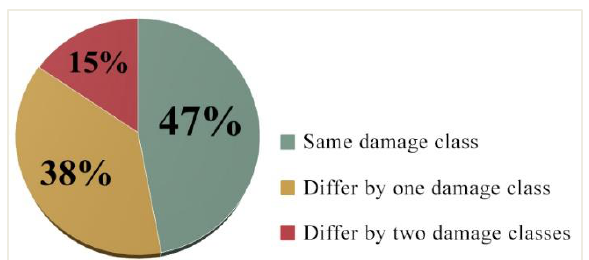
Figure 12. Comparison, in terms of surface occupied by buildings, between the two DDE methods